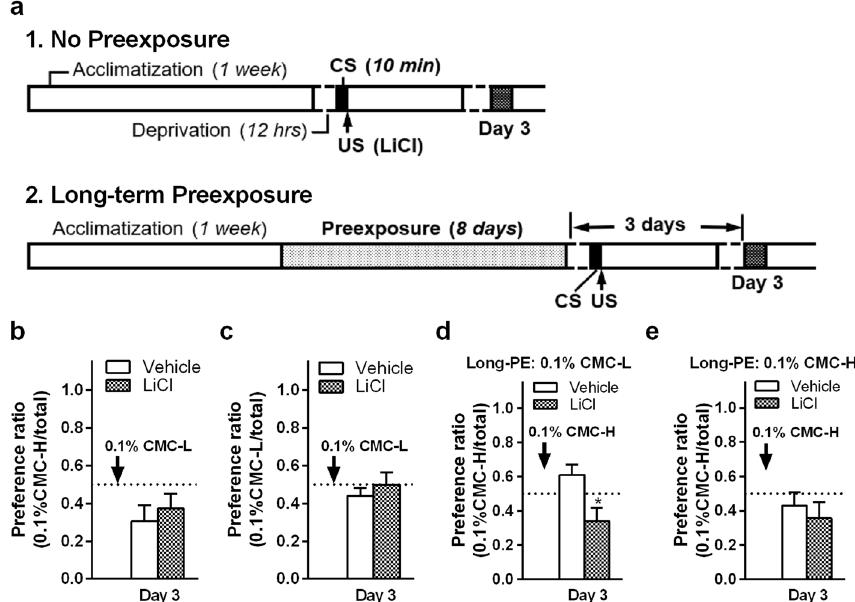
Figure 3. Conditioned aversion tests to 0.1% low- or high-viscosity carboxymethyl cellulose (CMC)-containing fluids 3 days after lithium chloride (LiCl) injection (unconditioned stimulus [US]) following ingestion of a viscous fluid (conditioned stimulus [CS], indicated by an arrow in each graph). CMC-L, low-viscosity CMC fluid; CMC-H, high-viscosity CMC fluid. Mean ± standard error of the mean. ( a ) Either no pre-exposure or long-term (8 days) pre-exposure to CMC solutions was carried out before conditioning. A pre-exposure procedure was performed to acquire safe learning of the CMC taste in rats. ( b , c ) Without pre-exposure, preference ratio in water and 0.1% CMC-H ( b ) or 0.1% CMC-L ( c ) after LiCl injection following ingestion of 0.1% CMC-L as CS (each group, n = 5). ( d , e ) Following long pre-exposure to 0.1% CMC-L ( d ) or 0.1% CMC-H ( e ), preference ratio in water and 0.1% CMC-H after LiCl injection following ingestion of 0.1% CMC-H as CS (each group, n = 5). *, P < 0.05 against vehicle on the same tested day by unpaired two-tailed Student’s t test. PE,